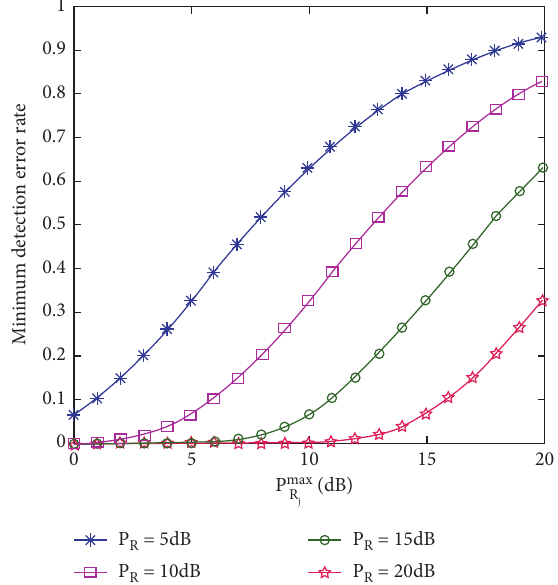
Figure 11: Minimum detection error rate versus P max ferent value of P R